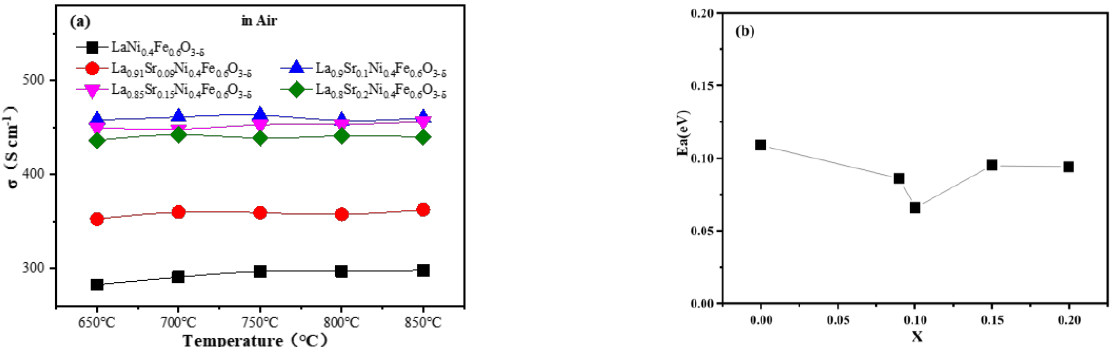
Figure 2. ( a ) Conductivity curves of La 1-x Sr x Ni 0.4 Fe 0.6 O 3- δ (x = 0.00, 0.09, 0.1, 0.15, and 0.20) oxides at 650